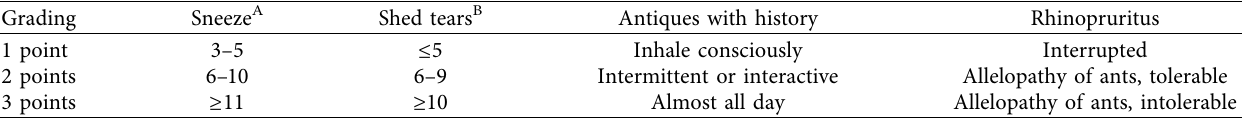
Table 1: Allergic rhinitis symptom rating scale.